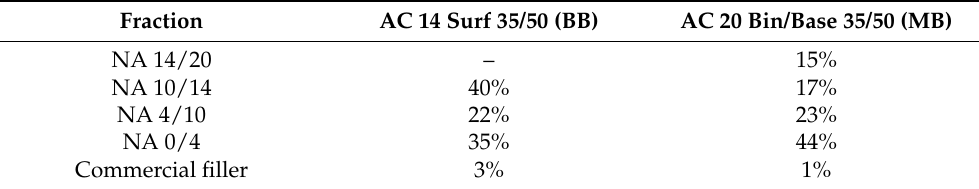
Table 10. Composition of the conventional asphalt mixtures with natural